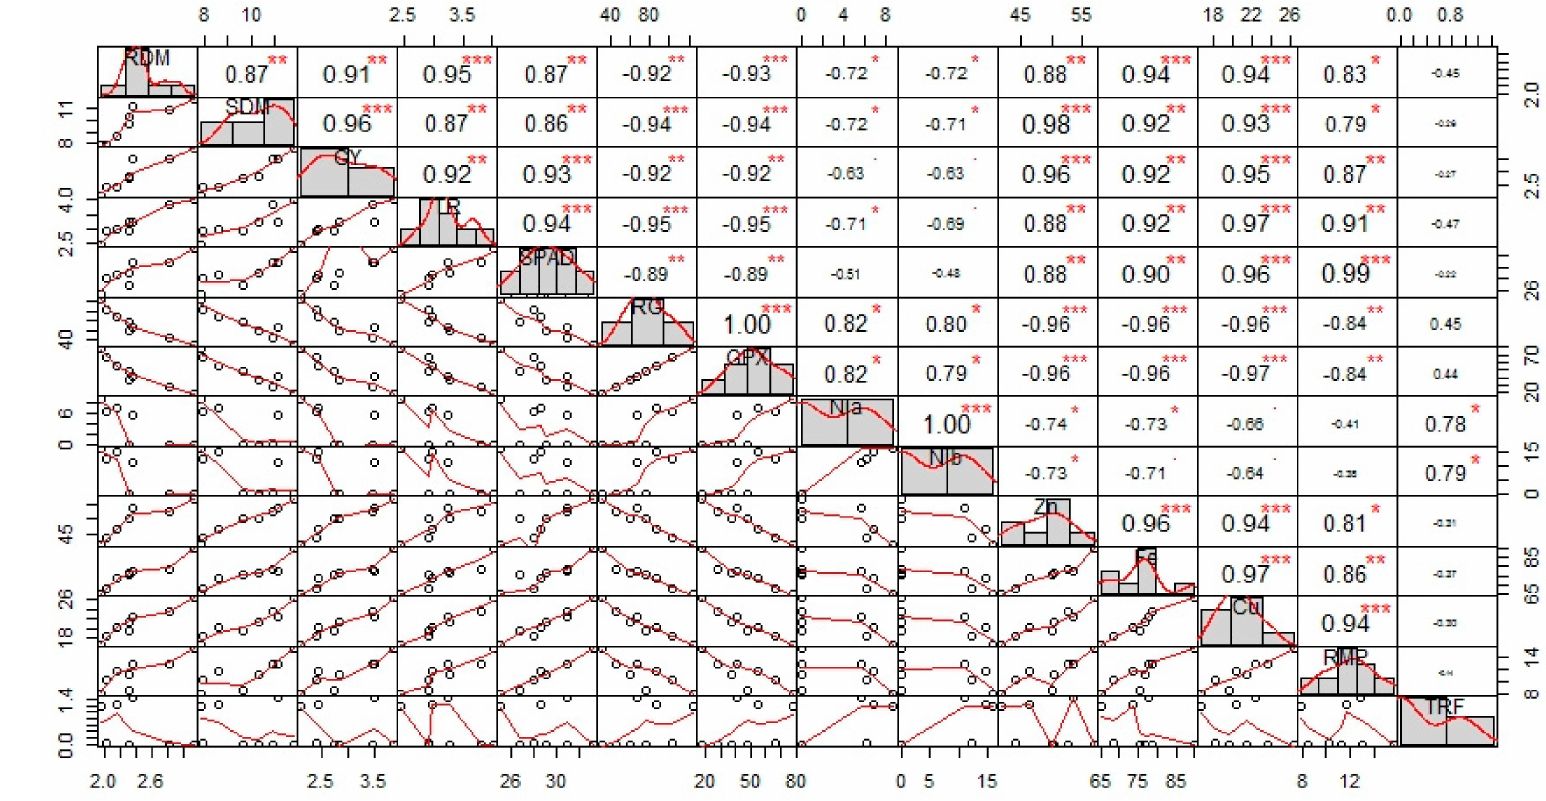
Figure 5. Correlation among di ff erent attributes of sesame plant by di ff erent treatments as control, (1) Ni 0 mg kg − 1 (2) Ni 90 mg kg − 1 ; zeolite, (3) Ni 0 mg kg − 1 (4) Ni 90 mg kg − 1 ; Caulobacter sp. MN13, (5) Ni 0 mg kg − 1 (6) Ni 90 mg kg − 1 ; and Caulobacter sp. MN13 + zeolite, (7) Ni 0 mg kg − 1 (8) Ni 90 mg kg − 1 . The abbreviations are as RDM: root dry biomass, SDM: shoot dry biomass, GY: grain yield, CO 2 AS: CO 2 assimilation rate, TR: transpiration rate, SPAD: chlorophyll contents, RG: reduced glutathione, GPX: glutathione peroxidase, Nia: Ni in grain, Nib: Ni in shoot, Zn: Zn in shoot, Fe: Fe in shoot, Cu: Cu in shoot, Mn: Mn in shoot, and TRF: translocation factor. *, 0.7–0.8; **, 0.8–0.9; ***,